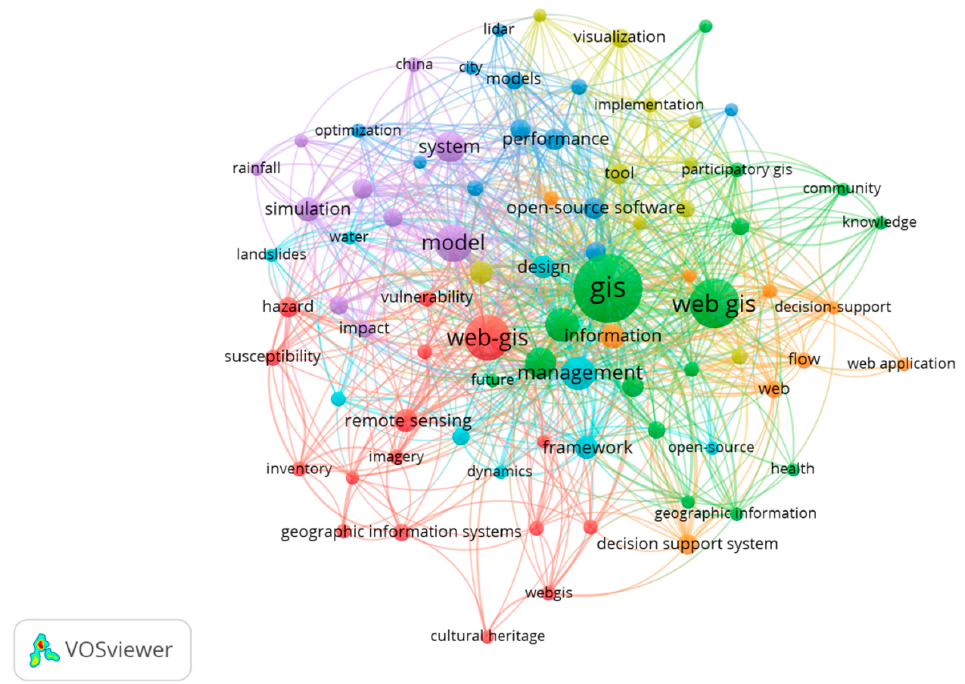
Figure 3. The network of co-occurrences of keywords in WoS database.